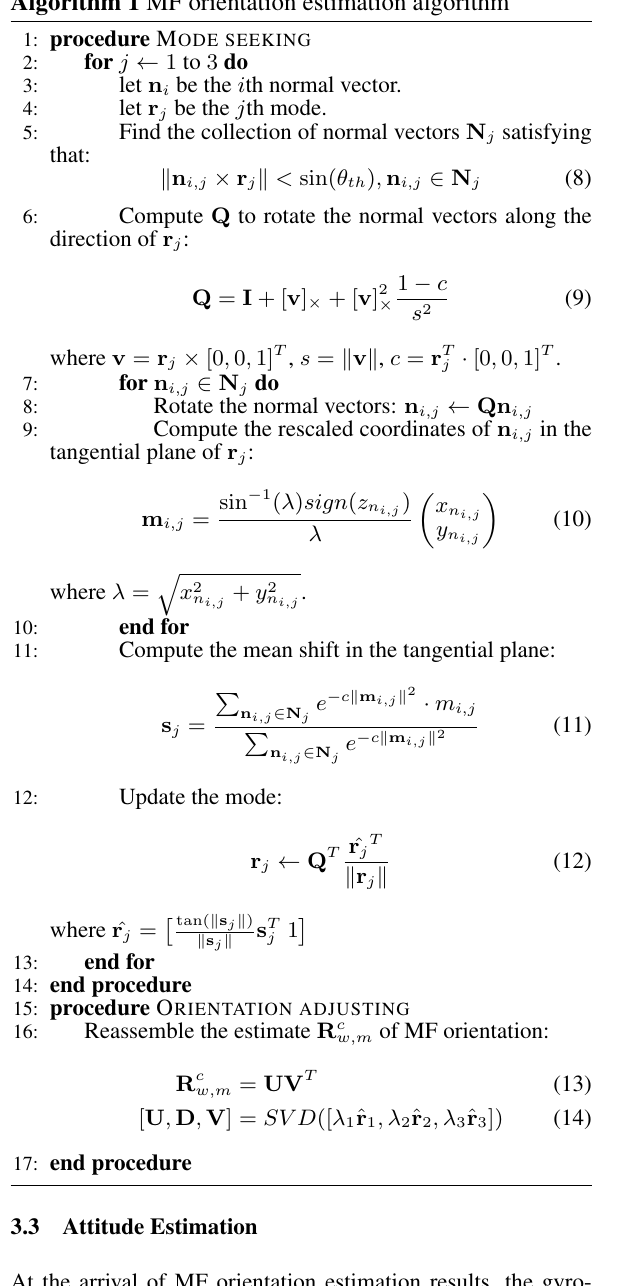
Algorithm 1 MF orientation estimation